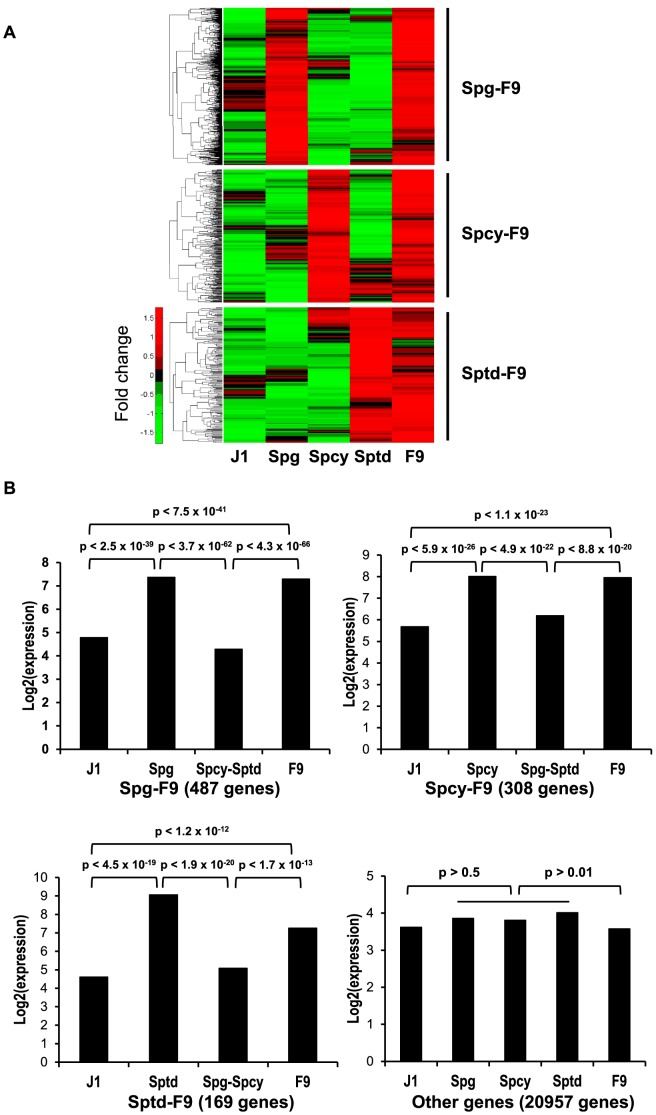
Microarray analysis of genes expressed stage-specifically in male germ cells and F9 cells.A. Heatmaps of the normalized gene expression profiles for each group. A total of 964 genes were expressed more than 1.5-fold higher in both a given germ cell stage and F9 cells compared to other germ cell stages and ESC. Clustering of each group was performed using hierarchical clustering. Up-regulated genes are indicated in red and down-regulated genes are shown in green. Abbreviations: J1, J1 embryonic stem cells; Spg, type B spermatogonia; Spcy, pachytene spermatocyte; Sptd, round spermatid; and F9, F9 cells. B. Mean expression level of all genes in each group. Differences between samples were validated using the Student's t-test. For simplification, the average expression levels between two germ cells with low expression levels were used. Significant differences were observed in the Spg-F9, Spcy-F9 and Sptd-F9 groups (p-value<10E-10).